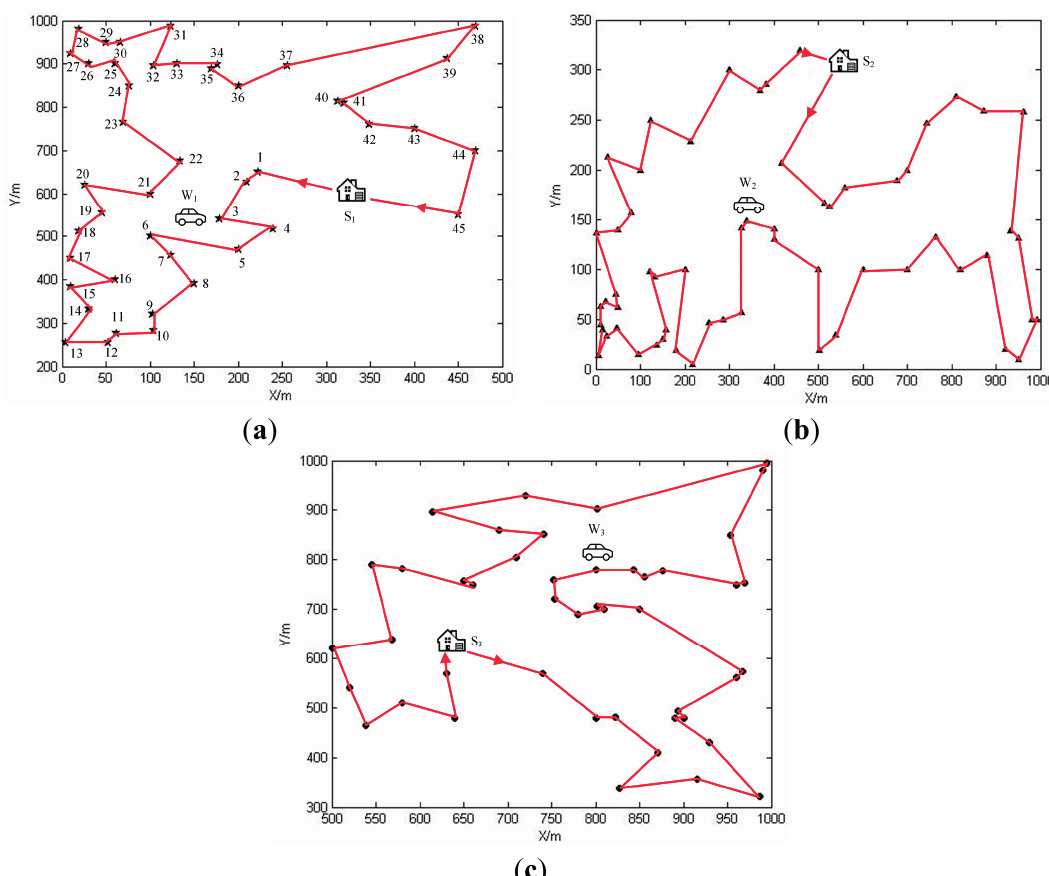
Figure 8. ( a ) The optimal travelling path